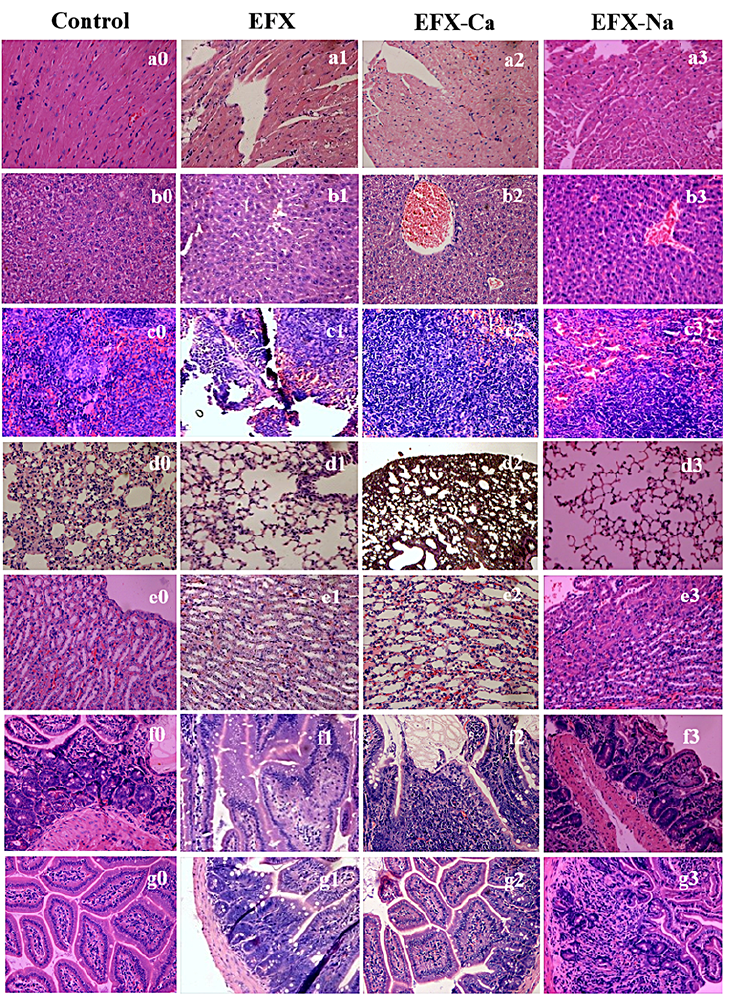
Figure 4. Histopathological images under 40 × magnification on the main organs from the dead mice after the oral administration of EFX, EFX-Na, and EFX-Ca, in which the histologic tissue slices of ( a ) heart, ( b ) liver, ( c ) spleen, ( d ) lung, ( e ) kidney, ( f ) large intestine, and ( g ) small intestine were stained and visualized. Number 0, 1, 2, 3 indicates the effect of EFX, EFX-Ca and EFX-Na for each organ, respectively.